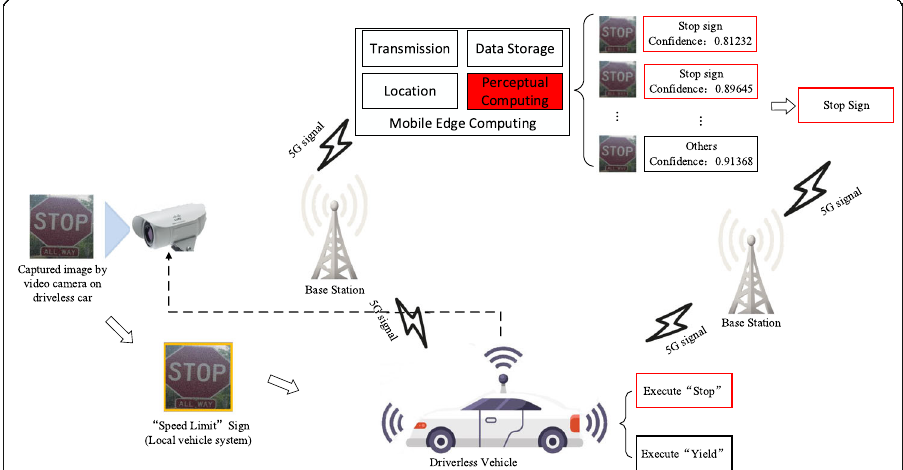
Fig. 6 The pipeline of our defense model (this figure shows the perturbed “ stop sign ” image uploads to the MEC node and processed by singular value decomposition. Then the MEC node sends the correct decision to the corresponding driverless car and helps it execute the right